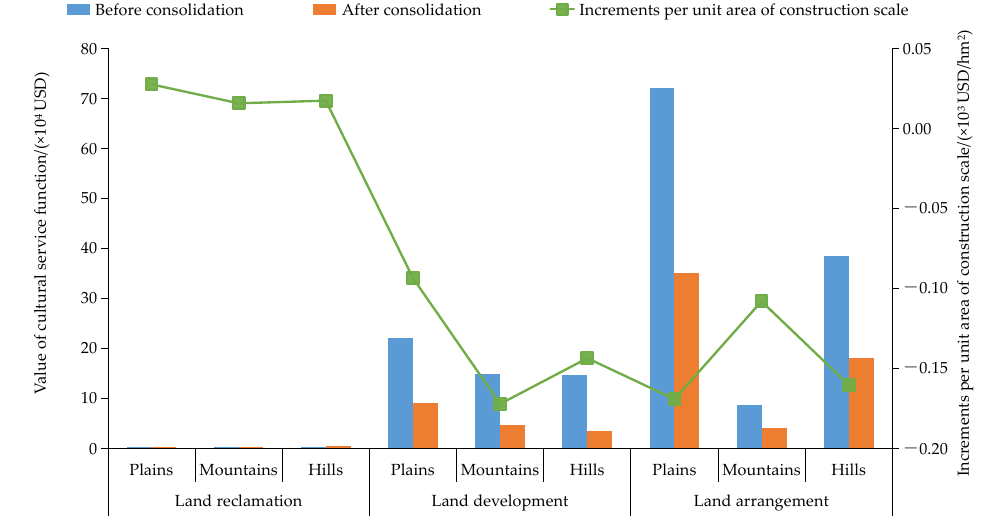
Figure 6. Change in value of cultural service function before and after consolidation in typical land consolidation project areas in Hubei province.